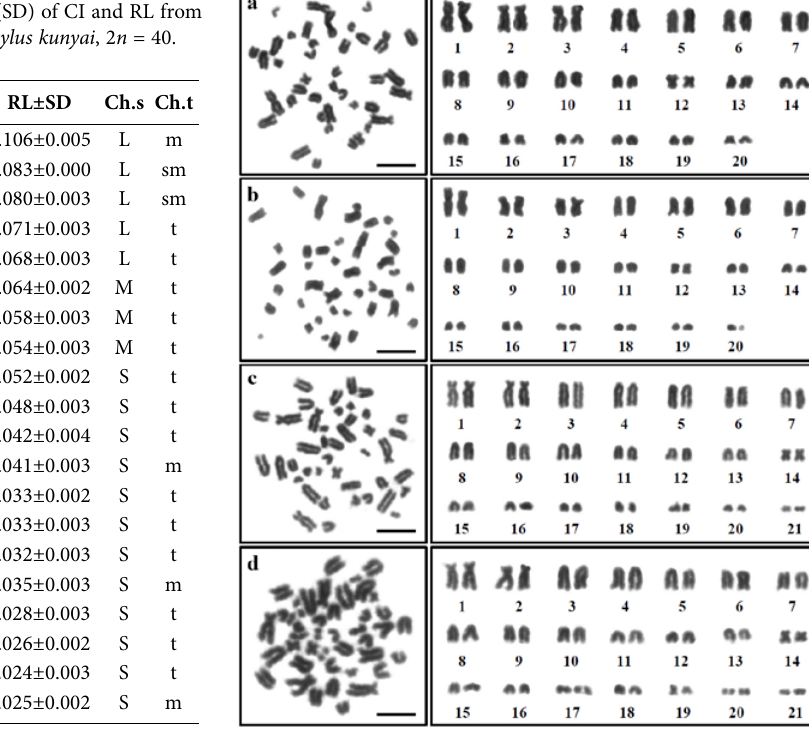
Fig. 2. Conventionally stained somatic metaphase complement and karyotypes of male (a) and female (b) of Cyrtodactylus kunyai , 2 n = 40, and male (c) and female (d) of C. interdigitalis , 2 n = 42, (scale bars = 10 μm).